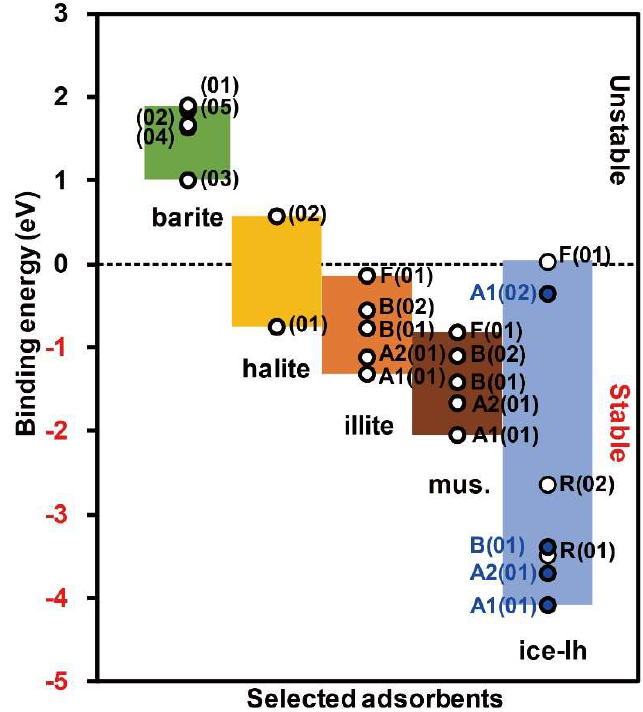
Figure 4. Calculated binding energies ( E Bind ) of Hg 2+ adsorption on the cleaved surfaces to compare the relative adsorption affinities of the selected adsorbents.